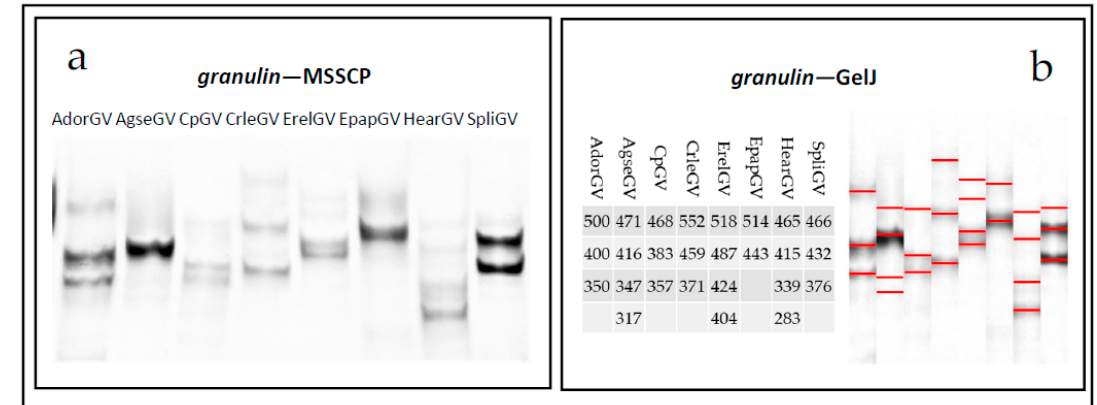
Figure 4. ( a ) Granulin gene fragments visualized with silver staining after Multitemperature Single Stranded Conformational Polymorphism analysis. ( b ) Table and picture generated by GelJ software. Different band patterns (marked with red lines) and calculated numerical fingerprints represent specific betabaculovirus species.